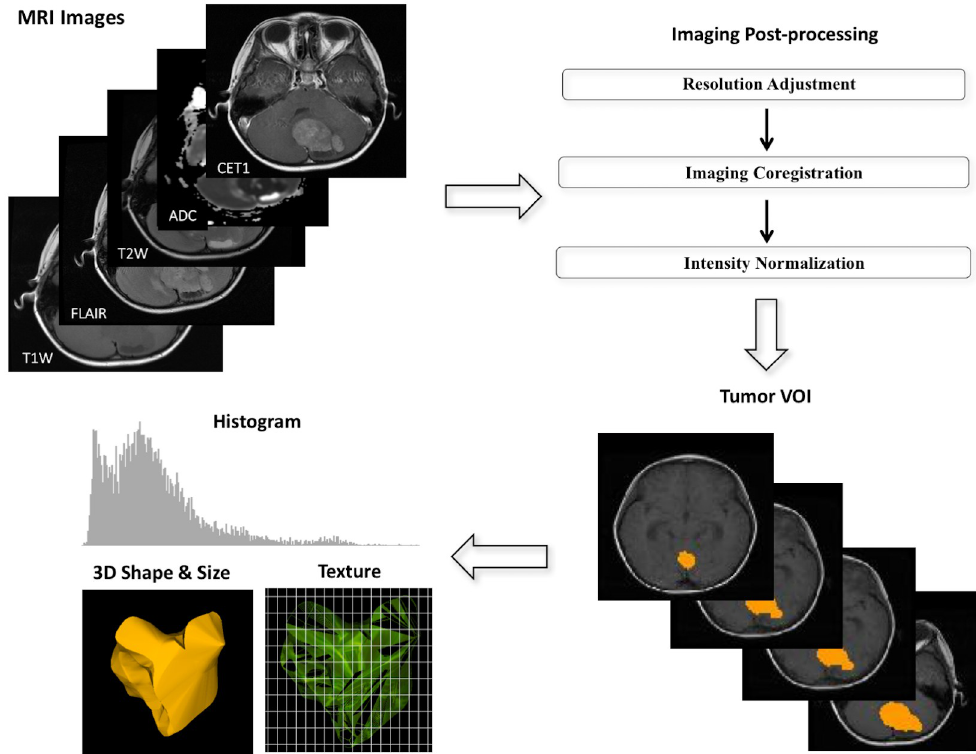
Fig 1. Diagram showing imaging process in radiomics. (a) Multiple postprocessing steps were applied to magnetic resonance images, including image coregistration, adjustment of image resolution, and intensity normalization between patients. (b) The volume of interest covering the total tumor was manually drawn by a neuroradiologist. (c) Three categories of radiomics, namely histogram, three-dimensional geography, and textural analysis, were employed on the processed magnetic resonance images to yield radiomic